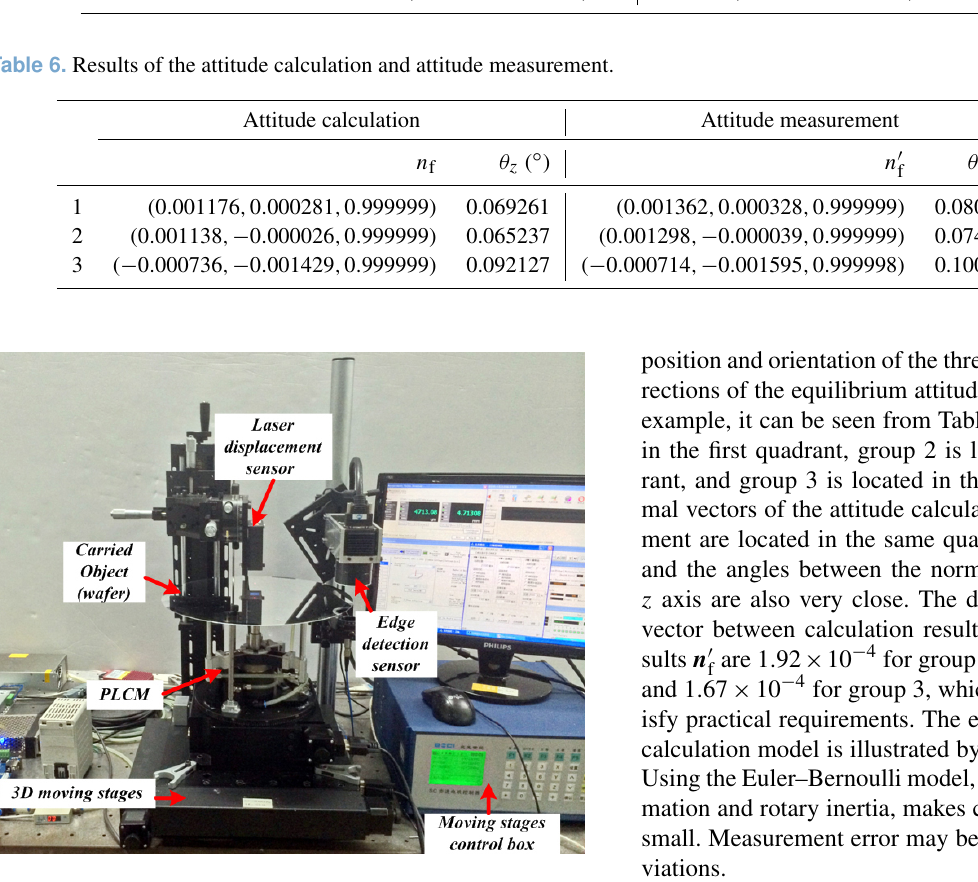
Figure 9. Experimental setup for attitude measurement of wafer